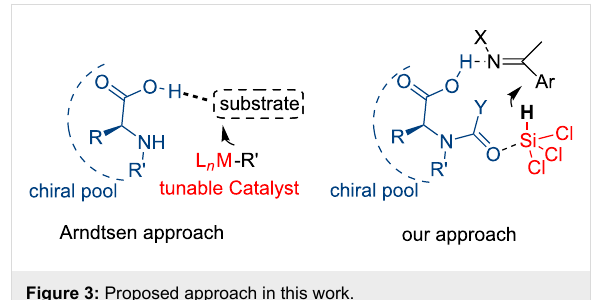
Figure 3: Proposed approach in this